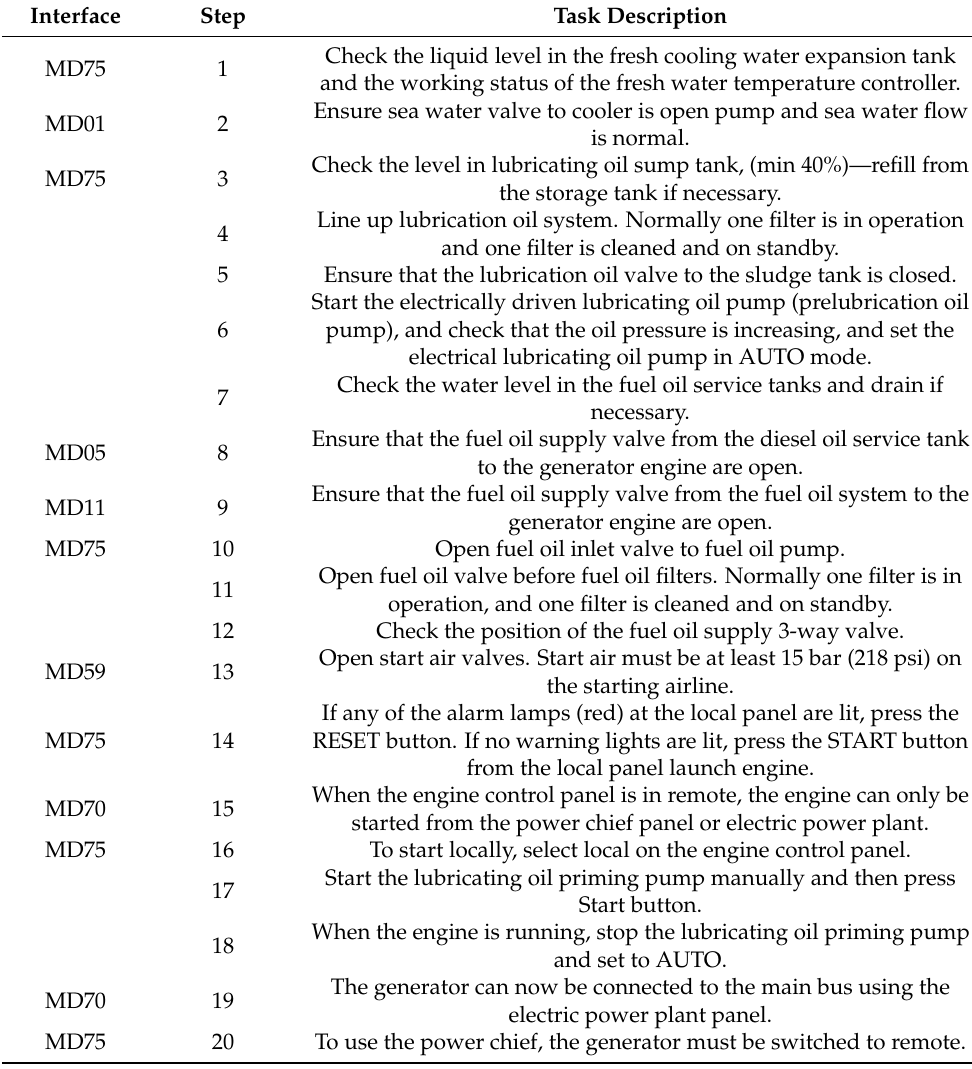
Table 3. The operating process for starting the diesel